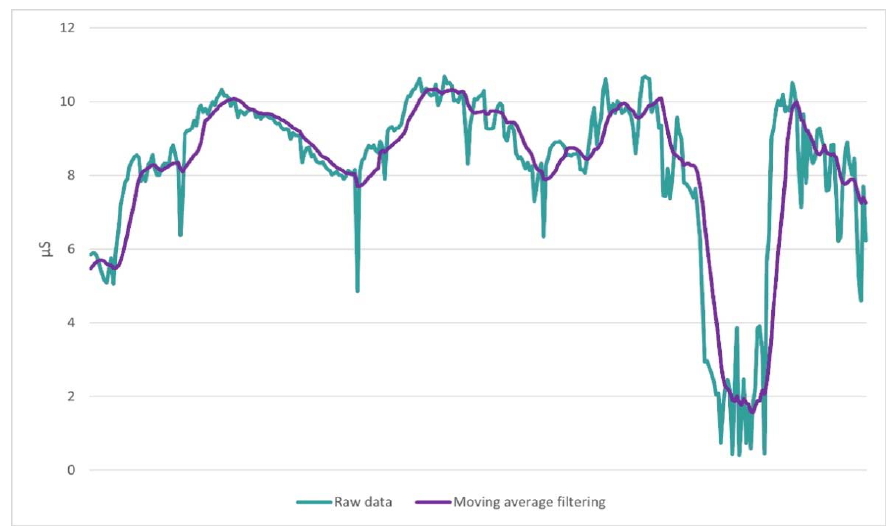
Figure 8. Application of the moving average filtering to the GSR signal. The green line depicts the raw data that are obtained from the sensor, before the preprocessing, while the magenta line depicts the same data after the application of moving average for a period of 10 measurements.